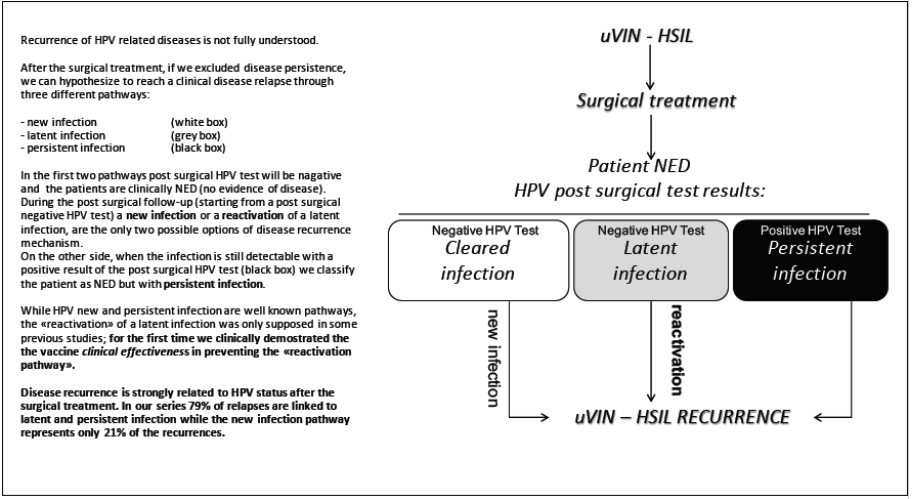
Figure 3. Schematic model of human papillomavirus (HPV) related disease